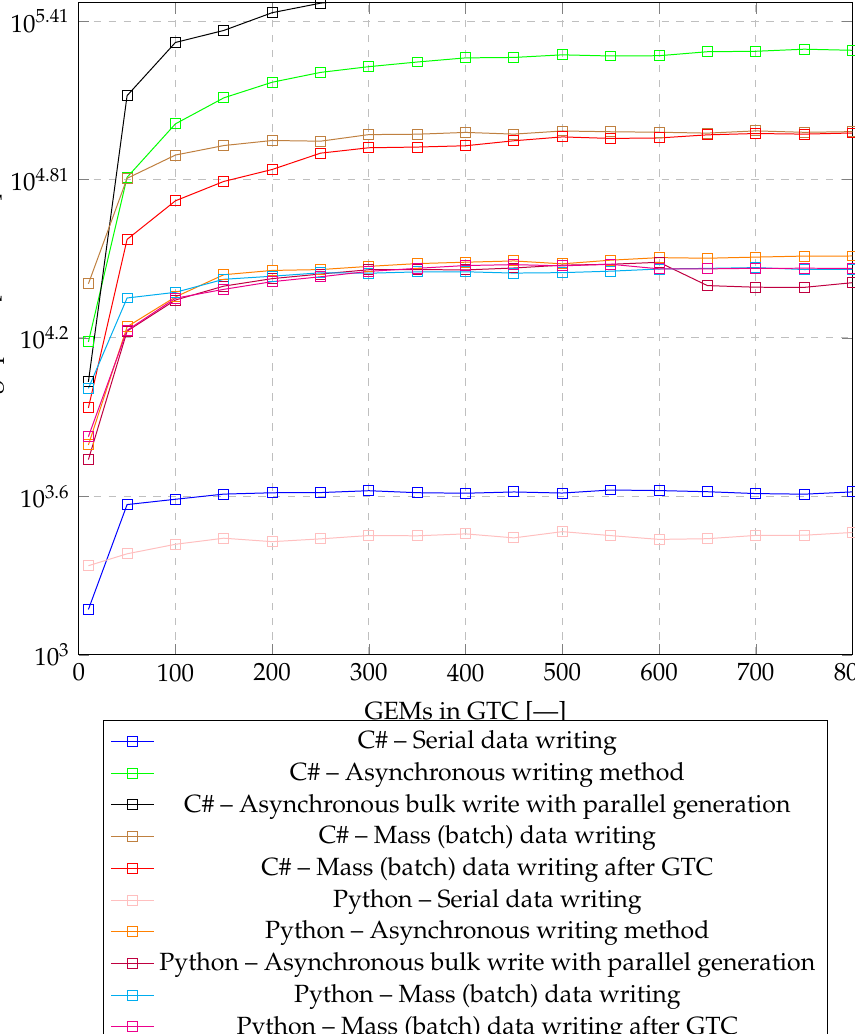
Figure 7. Graph of dependence of writing speed based on the used writing